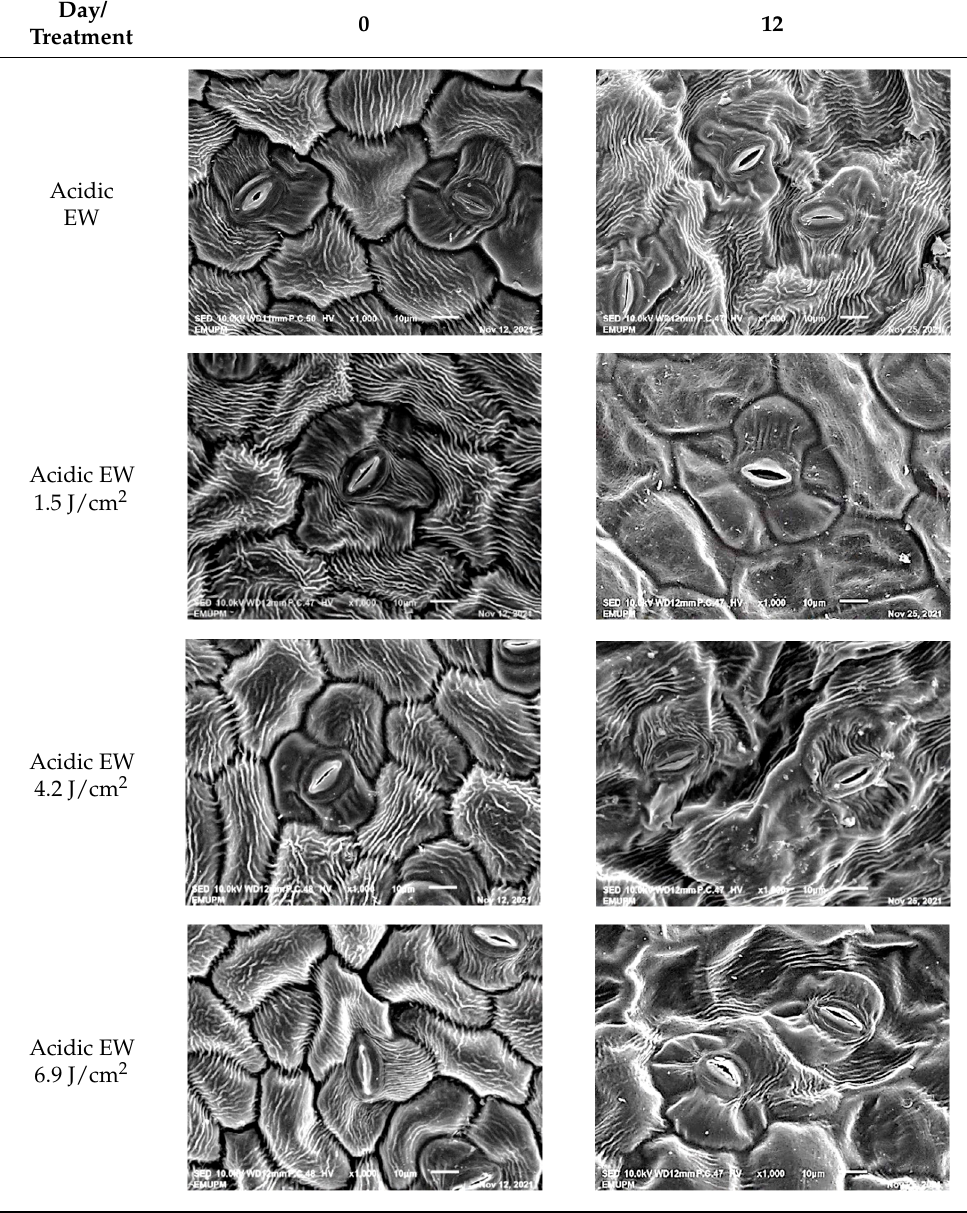
Table 1. Scanning electron microscopic (SEM) images of fresh-cut pennywort leaves on day 0 and 12 of storage period.